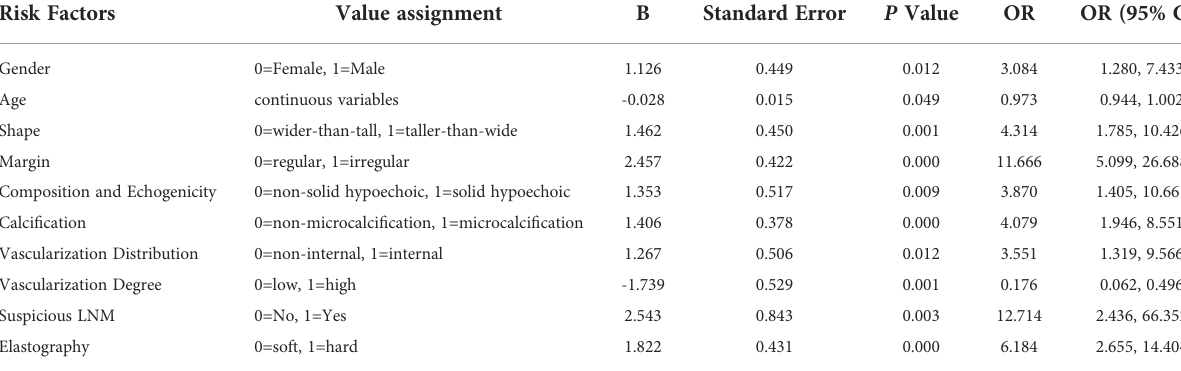
TABLE 2 Multivariate Analysis of risk factors for thyroid cancer in the training group.